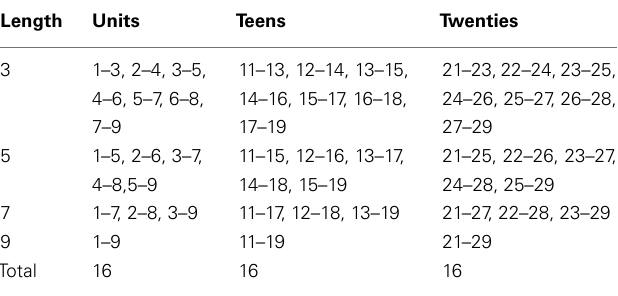
Table 2 |The complete set of number